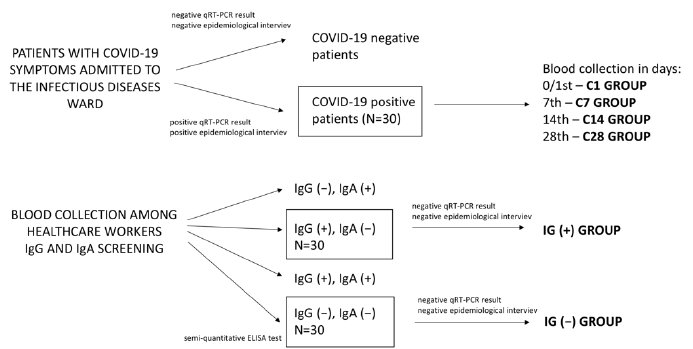
Figure 1. A brief diagram of the selection of patients and material collection.